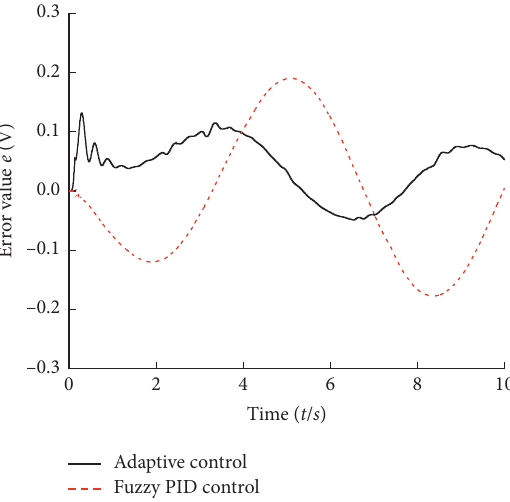
Figure 14: Sine signal before and after control.